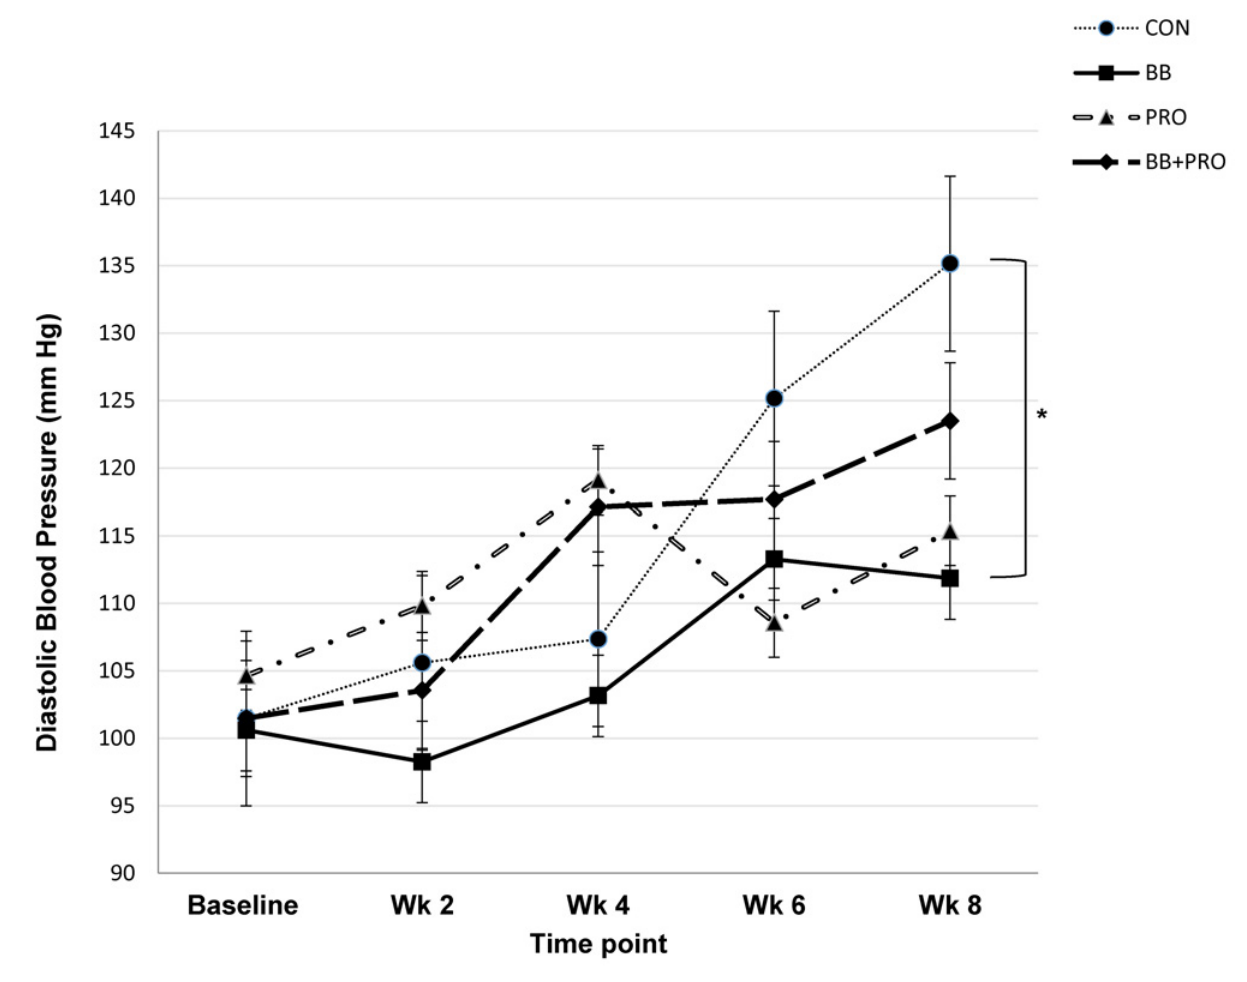
Fig 1. Diastolic blood pressure. Diastolic blood pressure of spontaneously hypertensive rats fed control (CON), 3% blueberry (BB), 1% probiotic (PRO), or 3% blueberry + 1% probiotic (BB+PRO) diet for 8 weeks. Data points are presented as means ± SEM for 8 rats in each diet group, with statistical analysis performed by mixed models ANOVA with repeated measures and post-hoc comparisons with Tukey ’ s adjustment. Diet exerted a significant main effect on diastolic blood pressure ( p = 0.046). Asterisk ( * ) indicates statistically significant difference between BB and CON rats across weeks 2 – 8 ( * p = 0.035). Within-week post-hoc comparisons between BB and CON rats showed no statistically significant differences when using Tukey ’ s adjustment; unadjusted p value for BB vs. CON at week 8 was p = 0.003 (S2 Dataset).